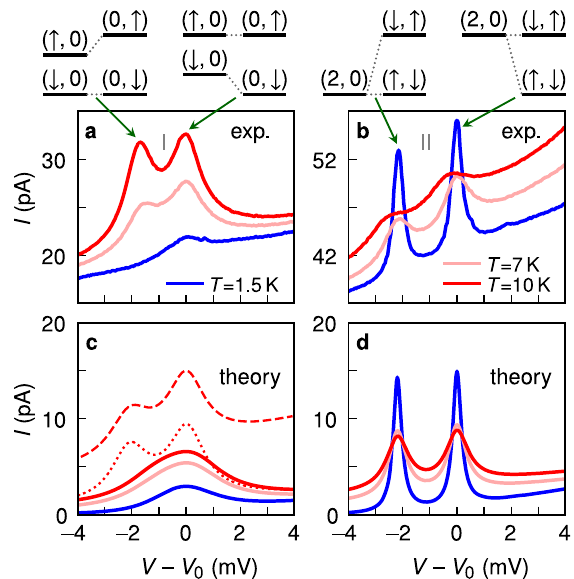
Fig. 4 In fl uence of a magnetic fi eld. a , b Temperature dependence of the current peaks at 155 mV ( a ) and 188 mV ( b ) in a magnetic fi eld with B = 4 T. The level schemes on top sketch the resonant processes that lead to the peaks as is explained in the text. c , d The theory curves computed with the inhomogeneity Δ E Z = 0.33 meV, such that for η = 0.15 the peaks are separated by 2.2 mV. All other parameters are as in Fig. 3. The additional lines in panel c are computed with a signi fi cantly larger α 0 ¼ 10 (cid:2) 5 (dashed line) and with additional spin fl ips (dotted, for details see the Supplementary Note VI: Additional spin fl ip